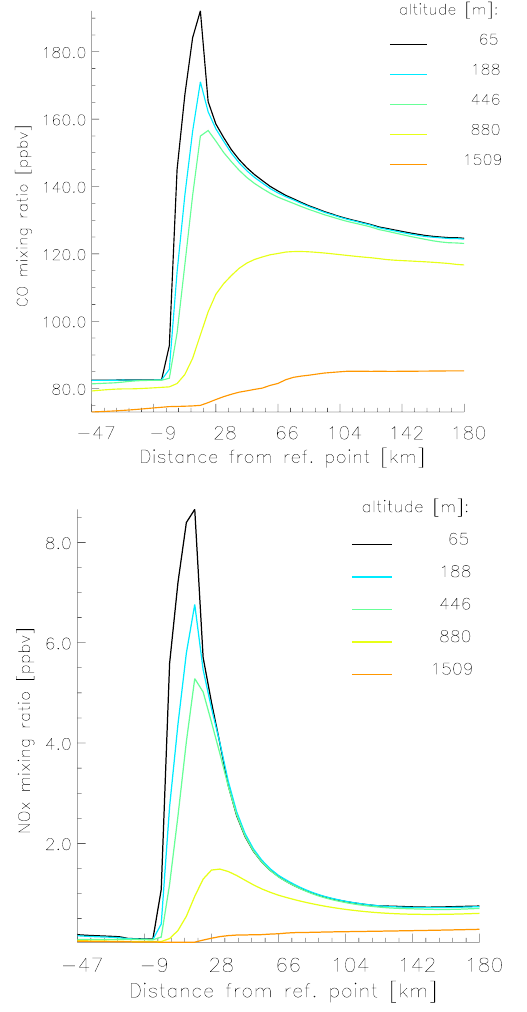
Fig. 14. Simulated CO (a) and NO x (b) mixing ratios for the 5 model layers that represent the convective boundary layer as a func- tion of the distance relative to the eastern city limits, with a positive value indicating the distance downwind.